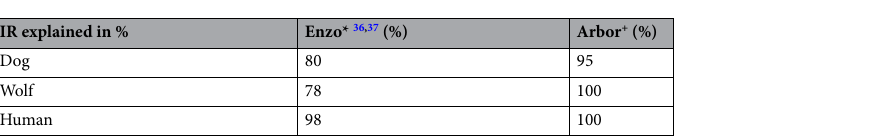
Table 3. Percent of total immunoreactivity (IR) detected in extracted urine explained by IR found in extracted oxytocin (OT) standard as measured by Enzo and Arbor OT assays. *Enzo Life Sciences, Assay Designs